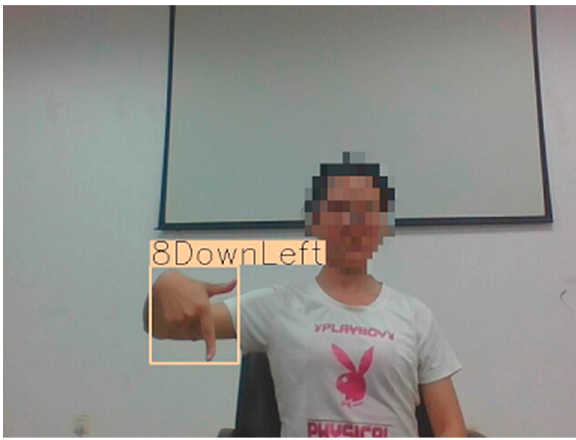
Figure 11. Result of recognition of hand postures in the conference room.